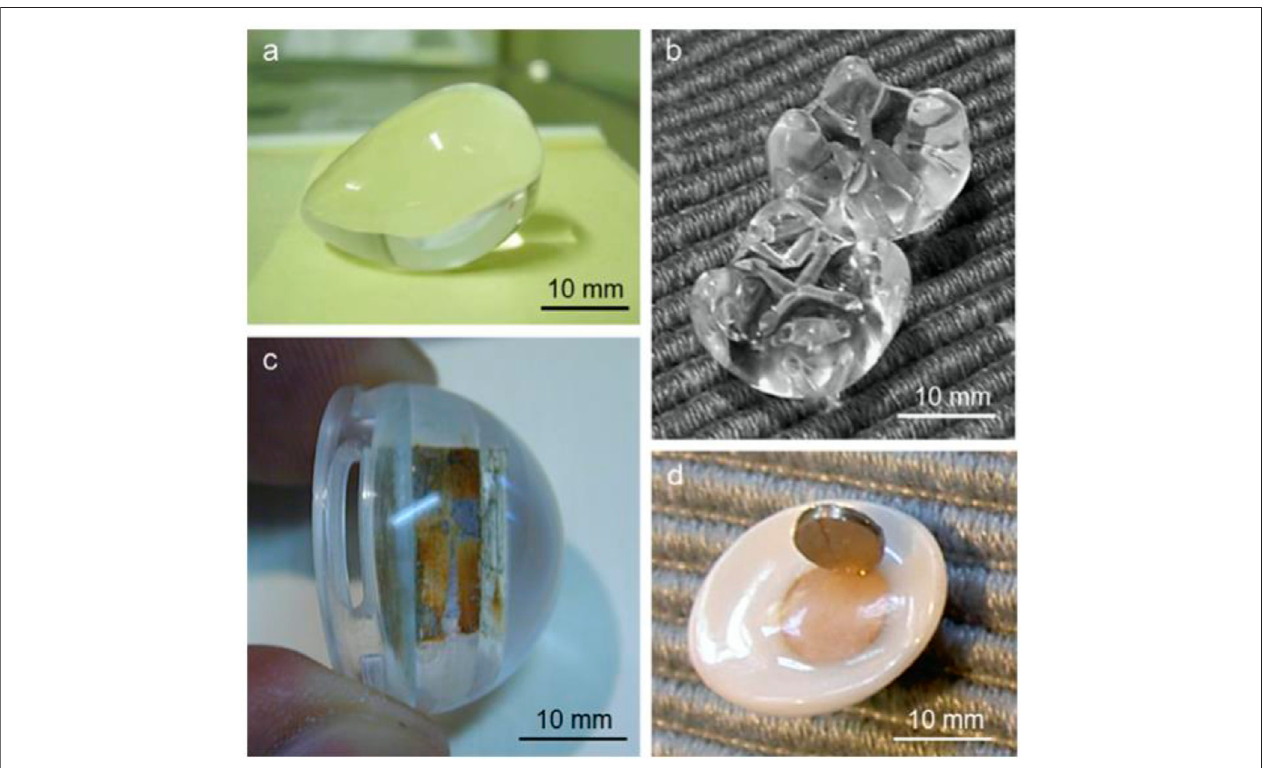
FIGURE 9 | Utilization of polymethylmethacrylate (PMMA) for the fabrication of orbital implants: (A) a pear-shaped implant (Sahaf implant type I); (B) a comparison betweentheIowaimplant(upward)andtheuniversalimplant(downward),demonstratingthatthelatterhassoftermoundsincomparisonwiththeIowapredecessor; (C) a magnetic orbital implant; and (D) an associated ocular prosthesis that exhibits magnet rusting in both components. Reproduced with permission from (Sami et al.,